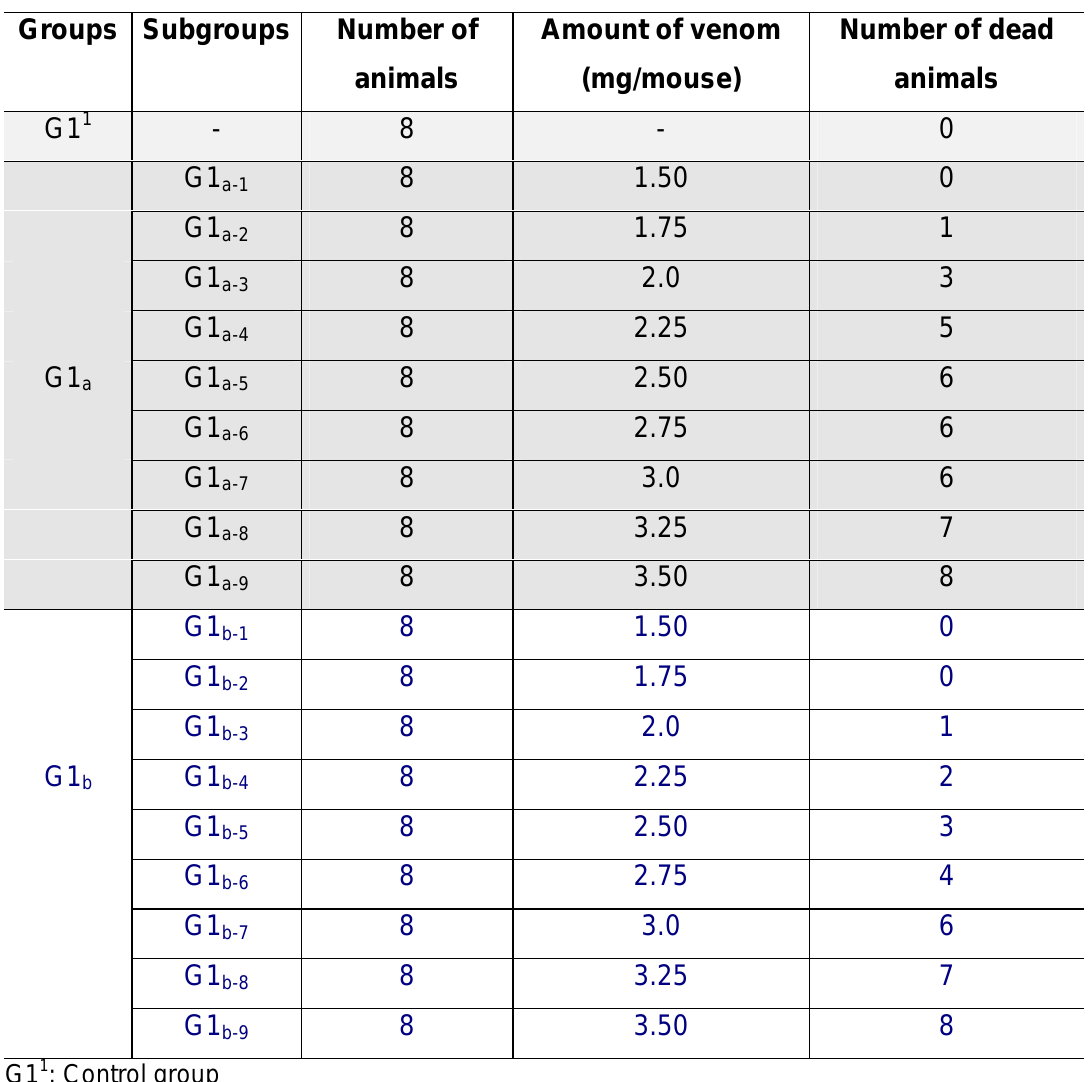
Table 2A: Number of animals in each subgroup, amount of venom used, and number of dead animals in Group 1 (injected with venom solution from telsons weighting from 30 to